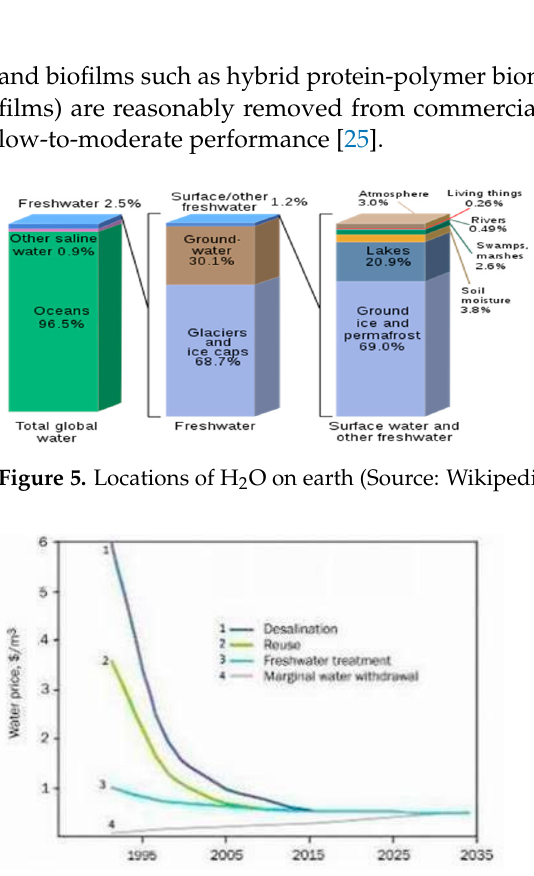
Figure 6. Anticipated cost/m 3 for different sorts of water.